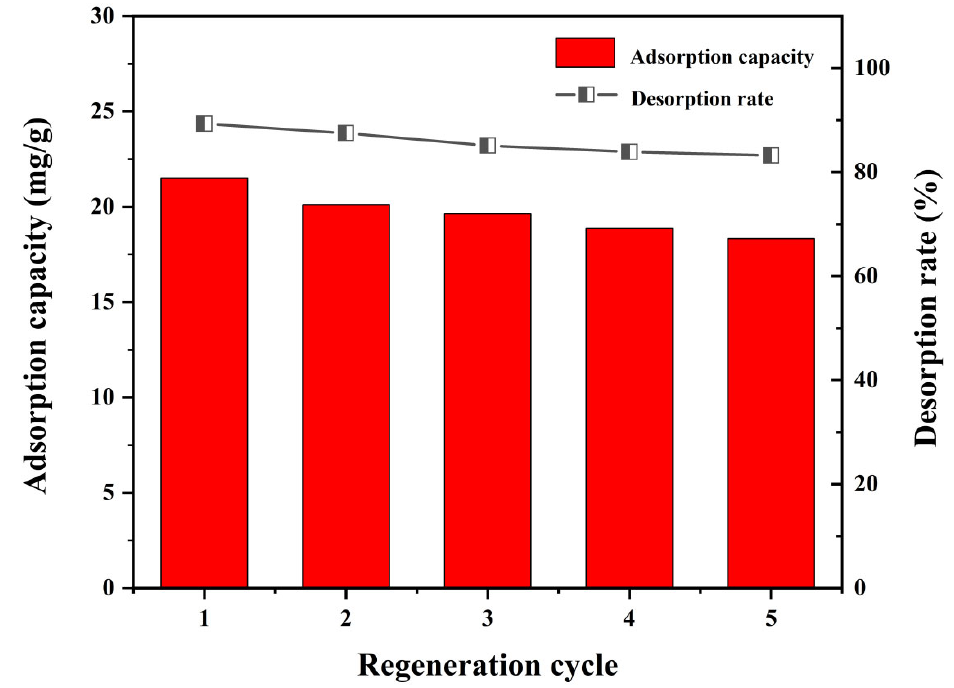
Figure 10. Variation of adsorption capacity and desorption rate by HNM ‐ 4 in regeneration cycle.